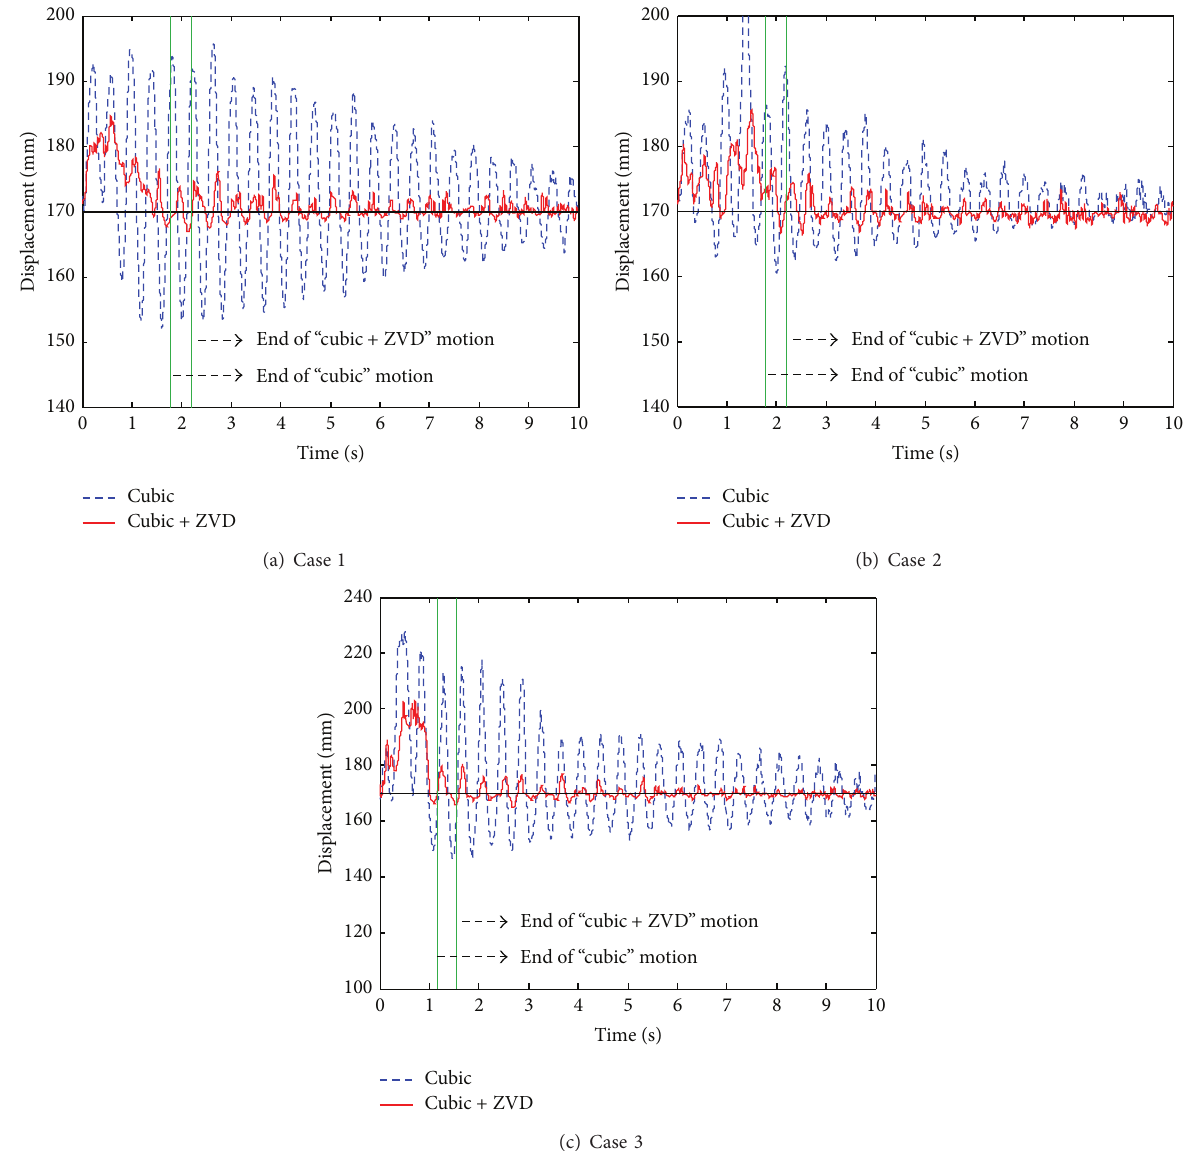
Figure 18: Sloshing measurement of (a) Case 1, (b) Case 2, and (c) Case 3.